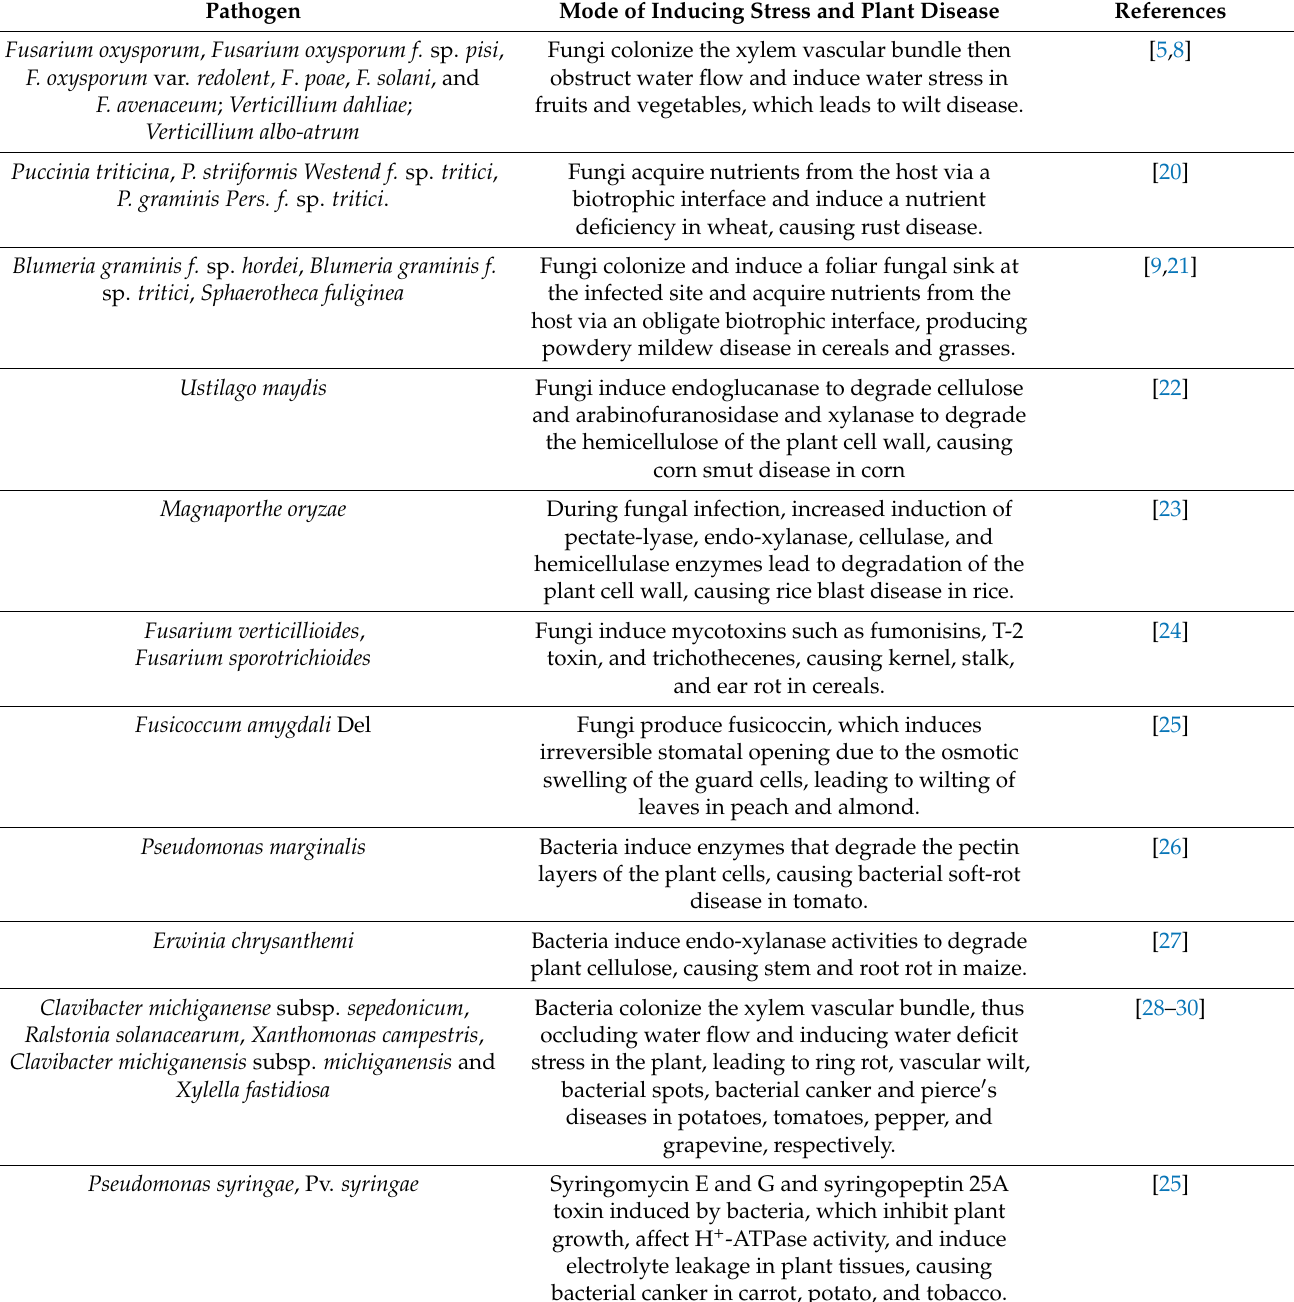
Table 1. Fungal and bacterial pathogen-induced stress in plants and their